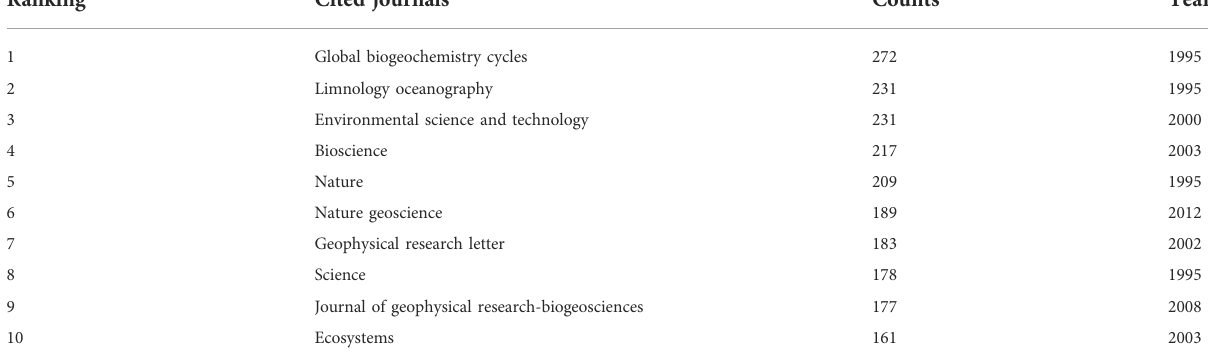
TABLE 6 Top 10 cited journals in GHG-HR research fi eld.